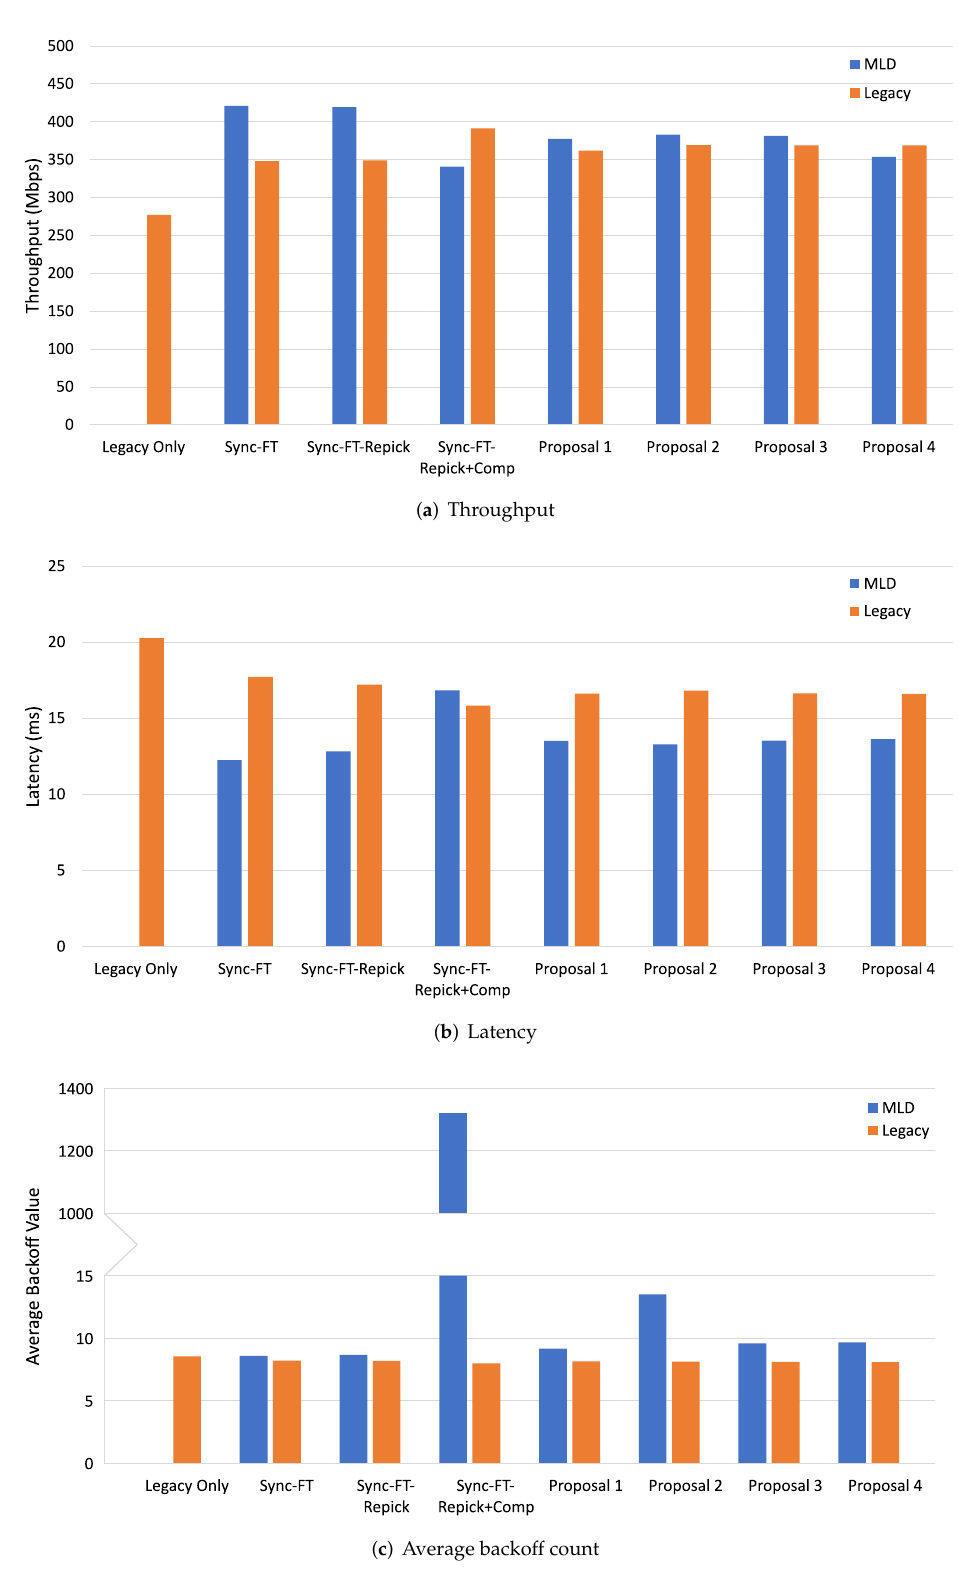
Figure 9. MLD vs. legacy SLD performance in the single-spot deployment